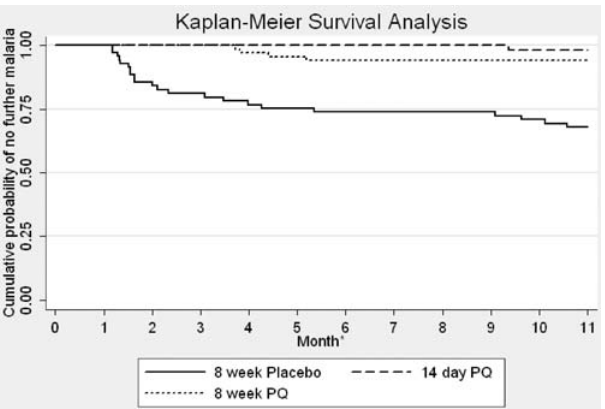
Figure 2. Kaplan Meier Survival Analysis, by treatment group, over 11 months of observation.